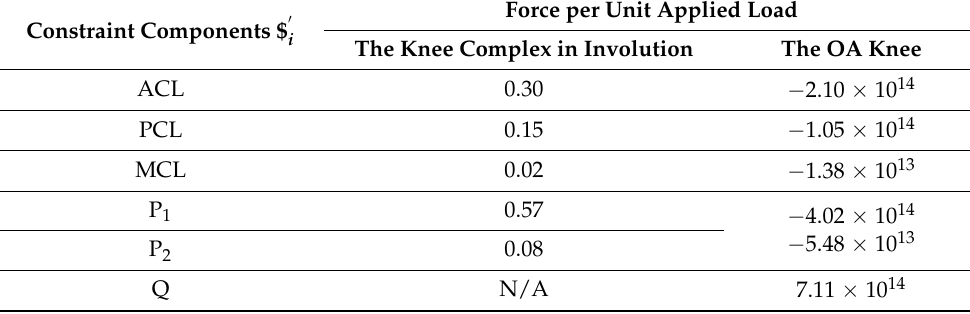
Table 1. Forces applied to the constraint components. Constraint Components $ (cid:48)